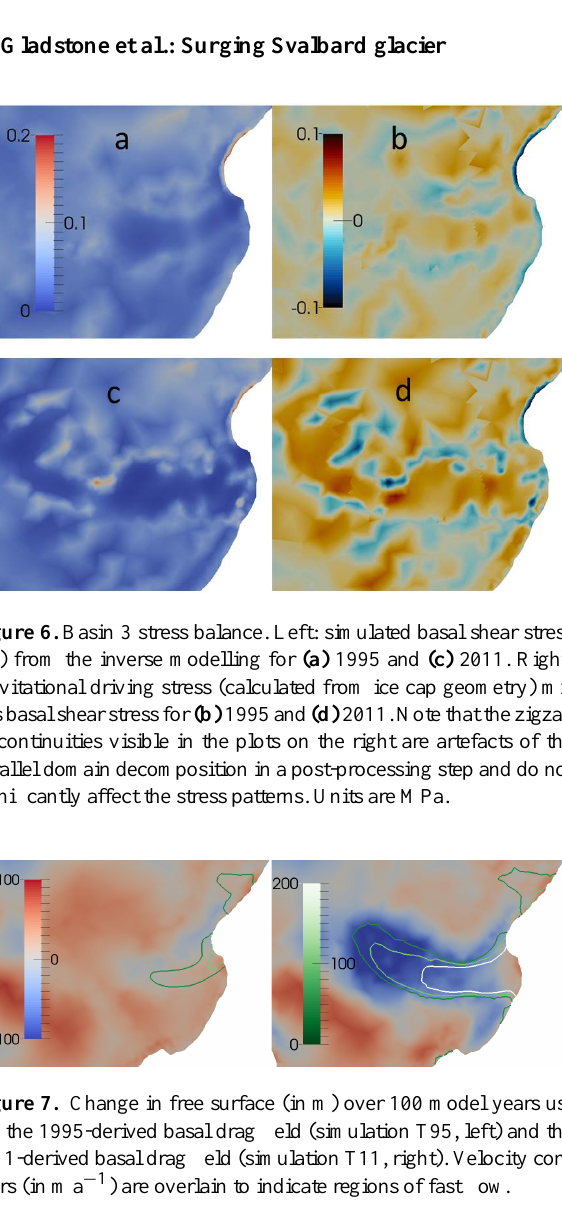
Fig. 7. Change in free surface (in m) over 100 model years using the 1995 derived basal drag field (simulation T95, left) and the 2011 derived basal drag field (simulation T11, right). Velocity contours (in ma − 1 ) are overlain to indicate regions of fast flow.